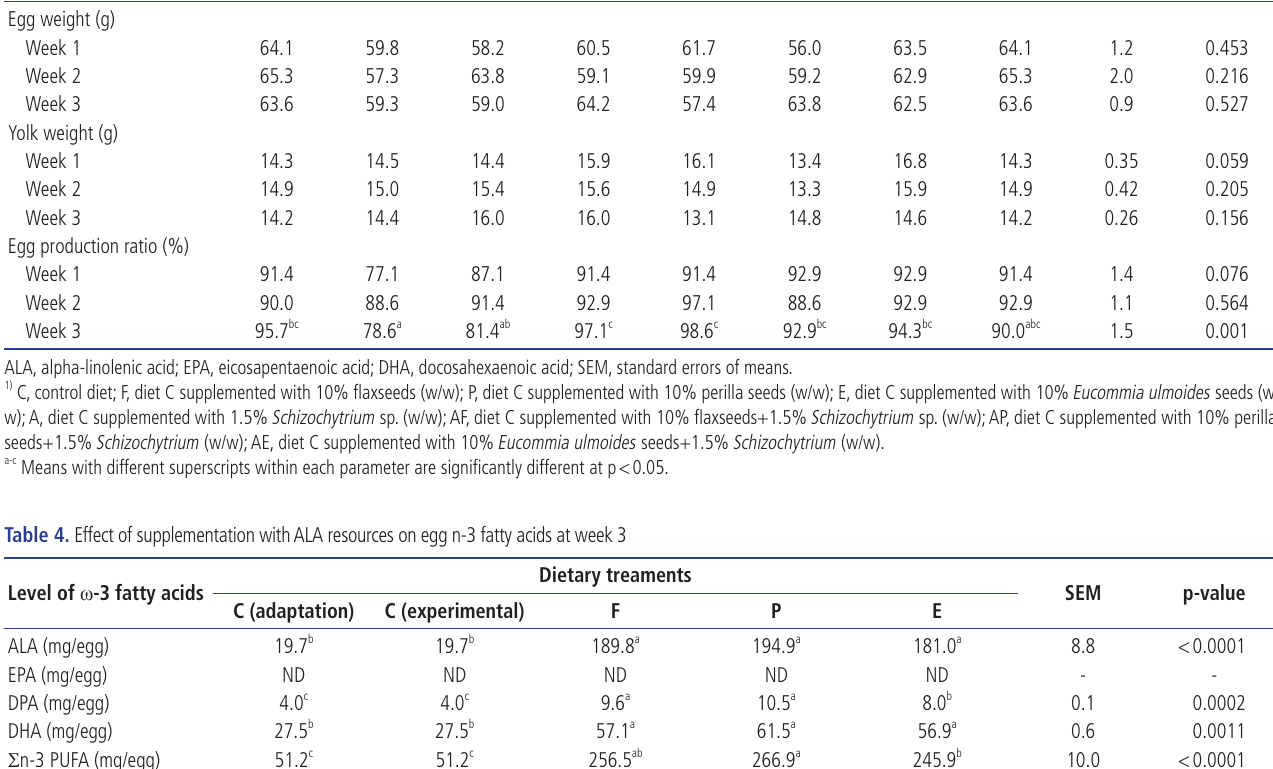
Table 3. Effect of supplementation with ALA and EPA/DHA resources on egg weight, yolk weight (g) and egg production ratio C 1)